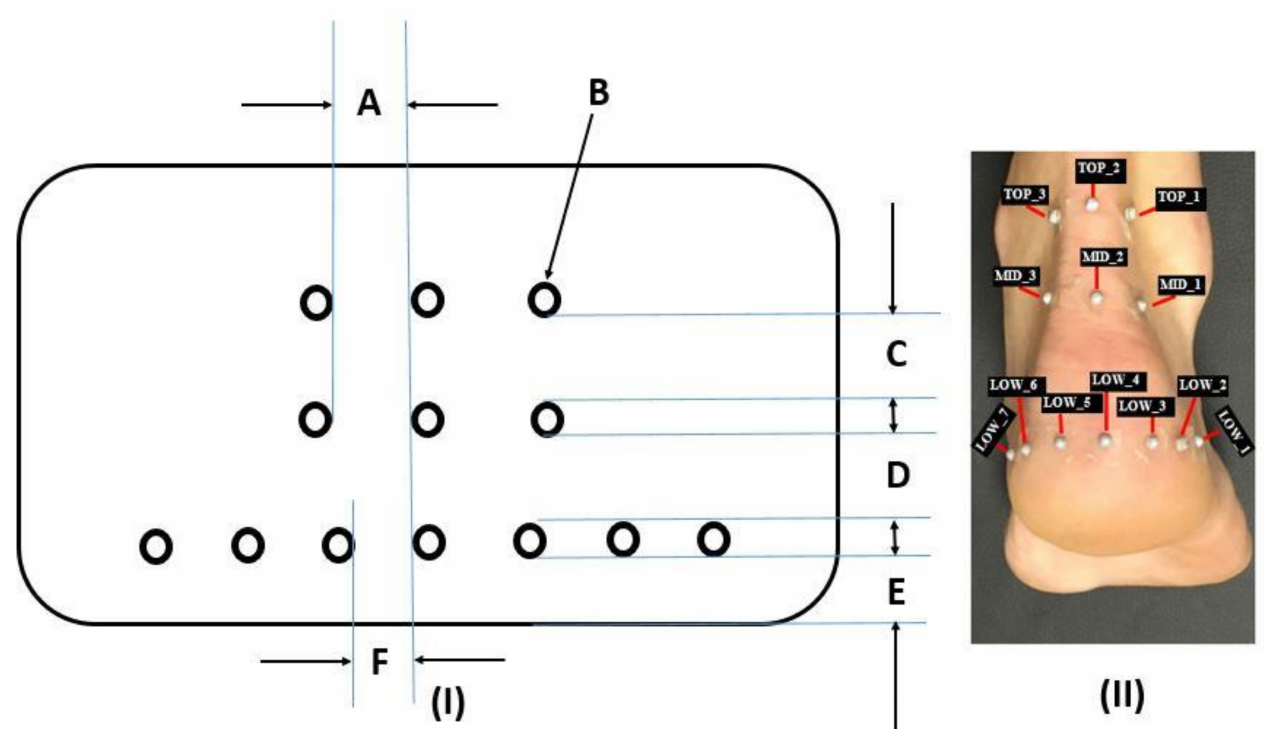
Figure 1. ( I ) : Custom designed template used to position the retroreflective markers on the heel. The internal dimensions were as follows: A represents the horizontal spacing distance for the TOP and MID retroreflective marker provisions (2 in number), B represents the 2 mm diameter perforated holes (13 in number), C represents the 2 cm vertical spacing distance between the TOP and MID retroreflective marker provisions, D represents the 2 cm vertical spacing distance between the MID and LOW retroreflective marker provisions, E represents the horizontal spacing distance for the LOW (bottom) markers (6 in number). ( II ): Pictorial illustration showing the retroreflective marker positions on the heel (Note: the size of the retroreflective markers are 3 mm in